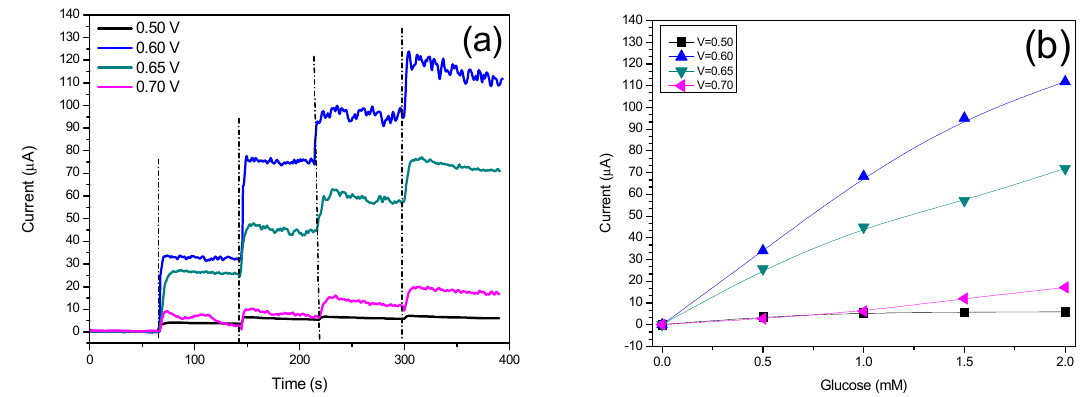
Figure 5. ( a ) Chronoamperometry of 20 µL N-CS/SPCE in 0.1 M KOH after successive additions of 0.5 mM glucose at different applied potentials and ( b ) corresponding calibration curves.